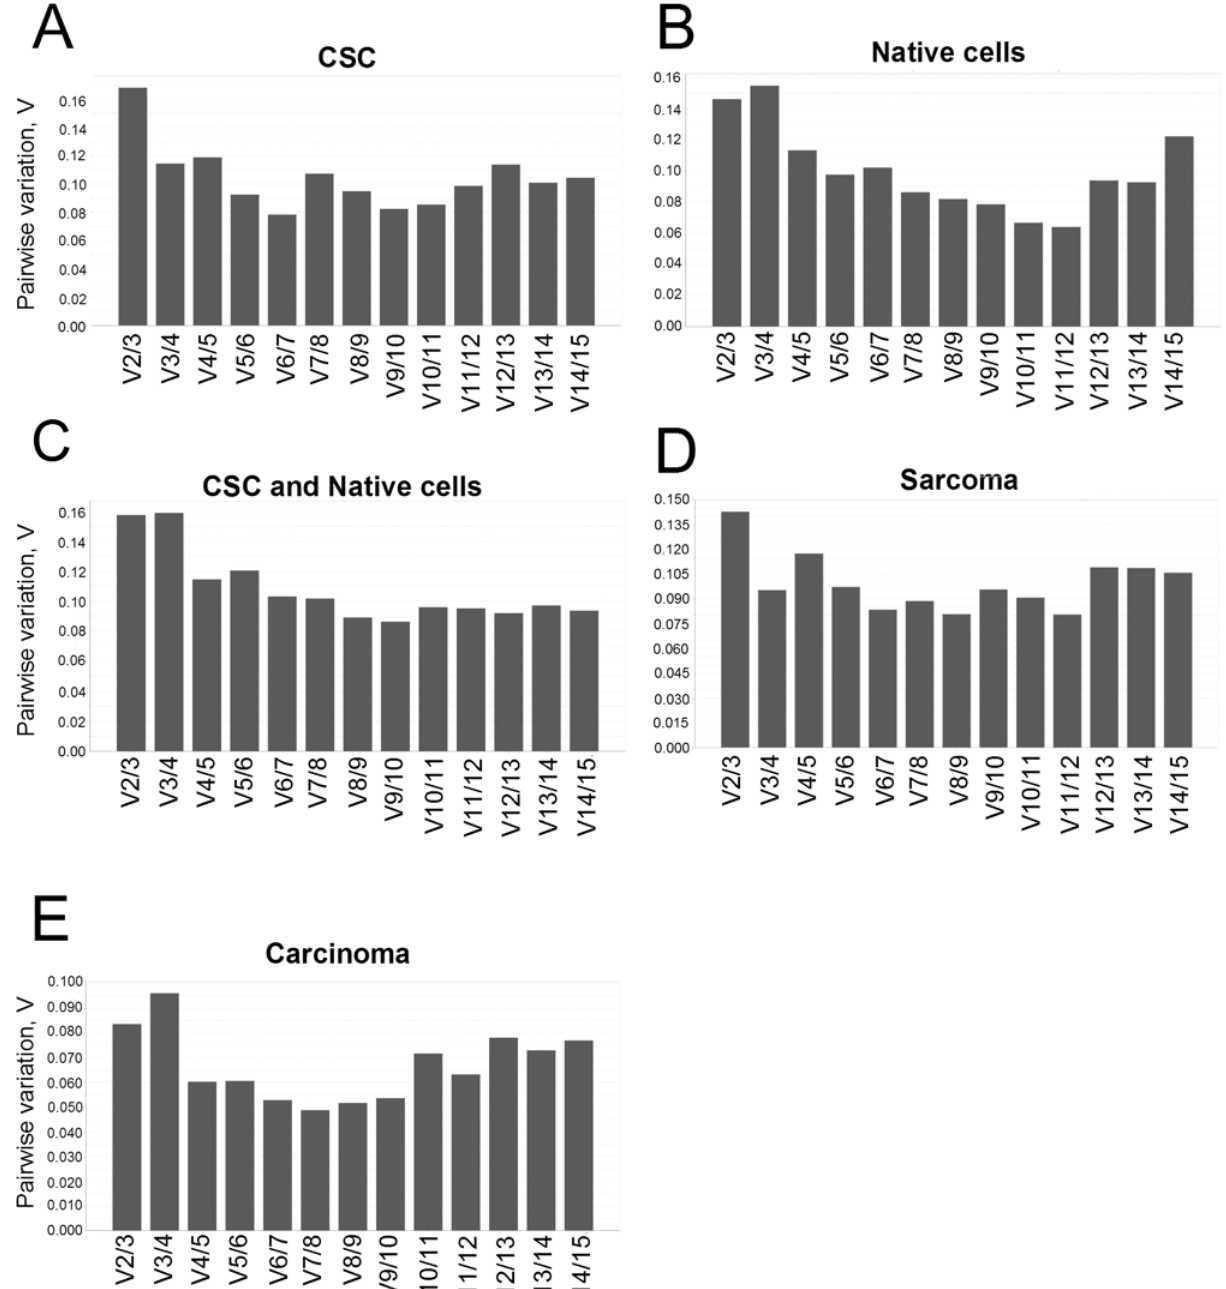
Fig 3. GeNorm evaluation of the minimal number of genes and validation of the identified top-ranked HKG genes for qRT-PCR normalization. The minimal number of genes required for data normalization was evaluated by pairwise variation (Vn/n +1) in (A) CSC, (B) native cells, (C) in the CSC and native cell lines from all tumors, (D) from sarcoma and (C) from carcinomas. A variation coefficient (V) below 0.15 indicates the optimal number of genes required for data normalization. V2/3 < 0.15 indicates that 2 genes are required for data normalization.